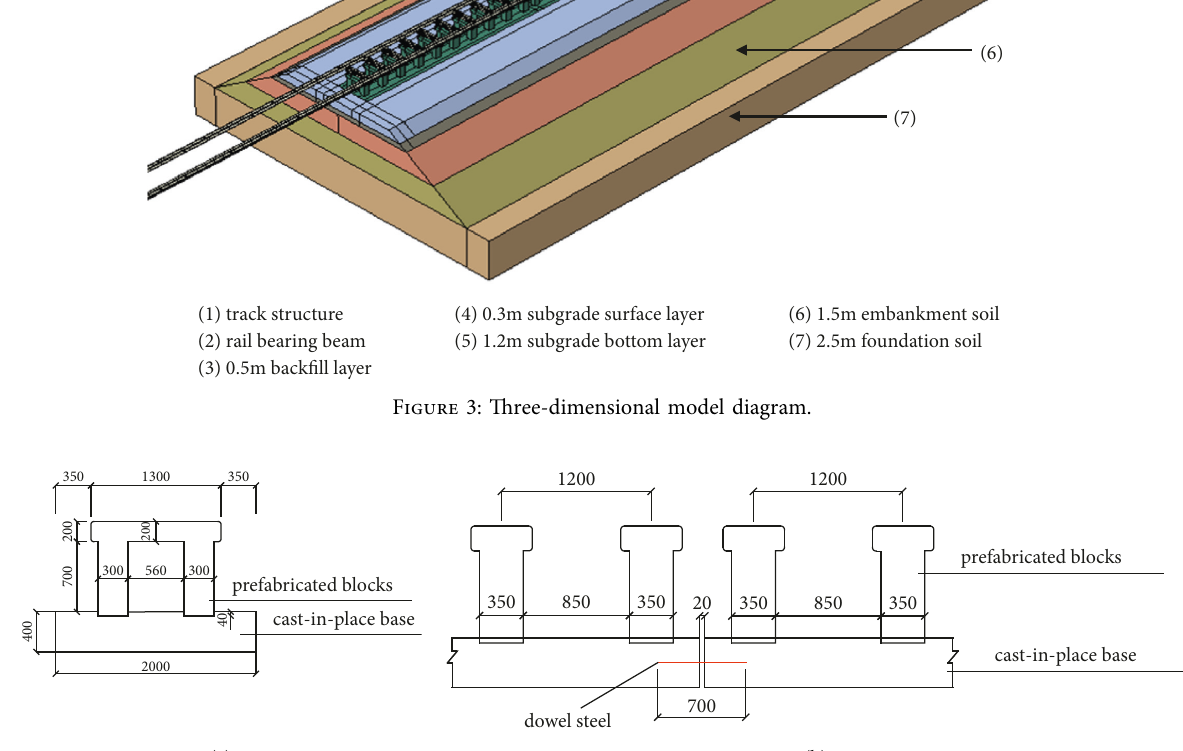
Figure 4: Rail beam specific structural dimensions (unit: mm); (a) cross-sectional diagram; (b) longitudinal diagram.